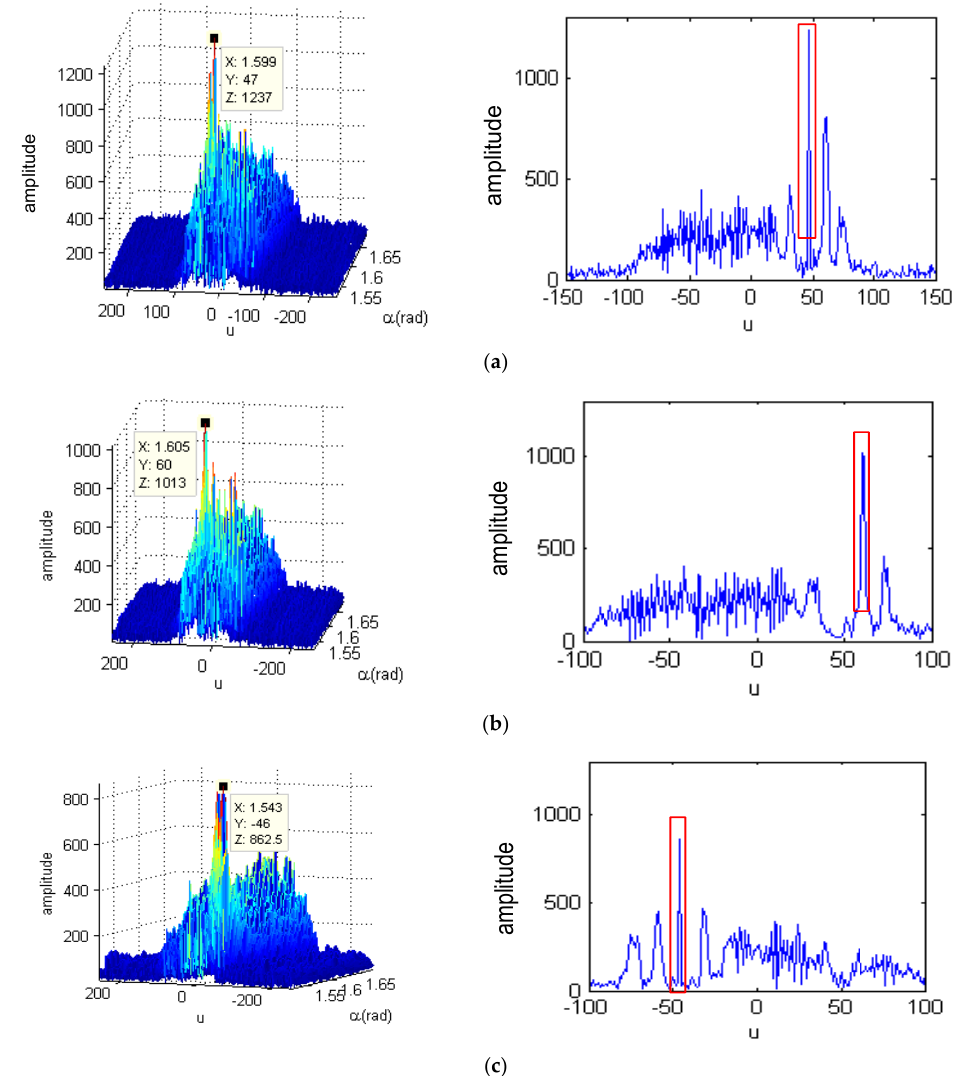
Figure 13. Separation imaging of the 95th range cell: ( a ) peak one, ( b ) peak two and ( c ) peak three.